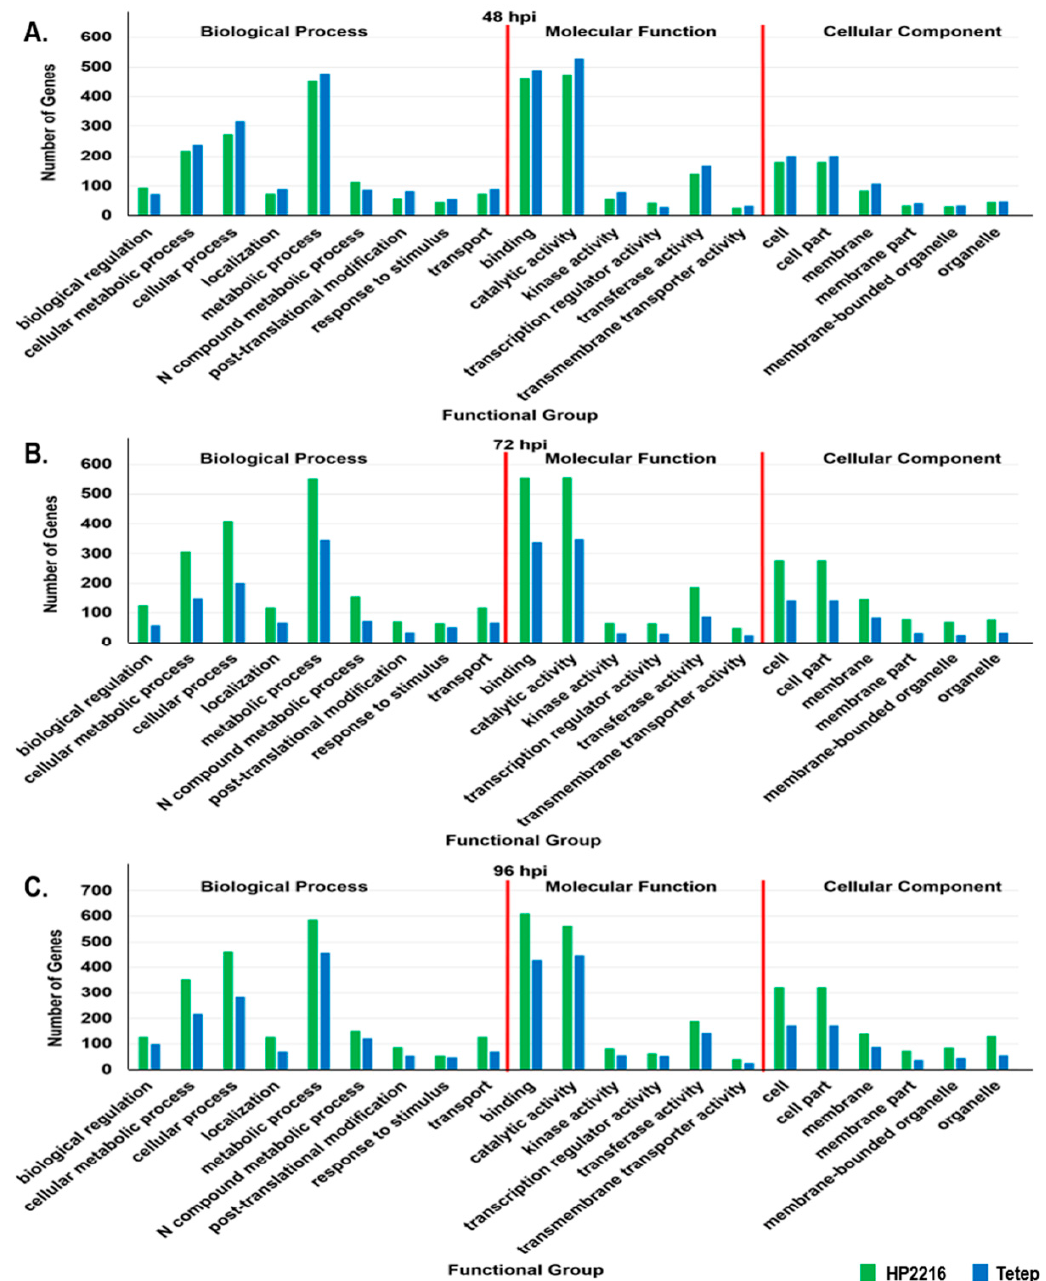
Figure 3. Gene Ontology for significant differentially expressed genes. Graphical representation of significant differentially expressed loci (SDEL; FDR adjusted p ≤ 0.01) in HP2216 comparative to Tetep present in different biological processes, molecular functions and cellular components of all significant GO terms at all three-time intervals. ( A ) Significant GO terms in HP2216 comparative to Tetep at 48 hpi. ( B ) Significant GO terms in HP2216 as comparative to Tetep at 72 hpi. ( C ) Significant GO terms in HP2216 comparative to Tetep at 96 hpi. GO terms for biological processes are biological